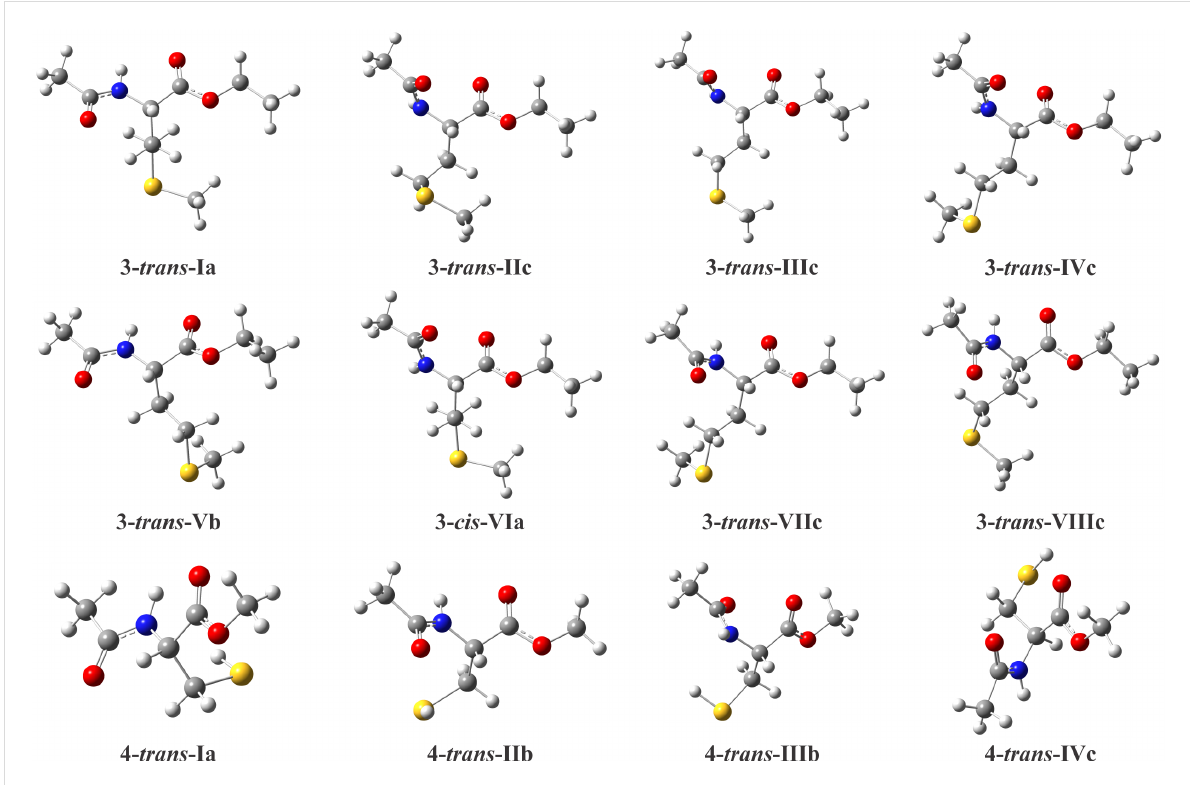
Figure 3: Most stable conformers of 3 and 4 obtained theoretically at the ω B97X-D/aug-cc-pVTZ level.